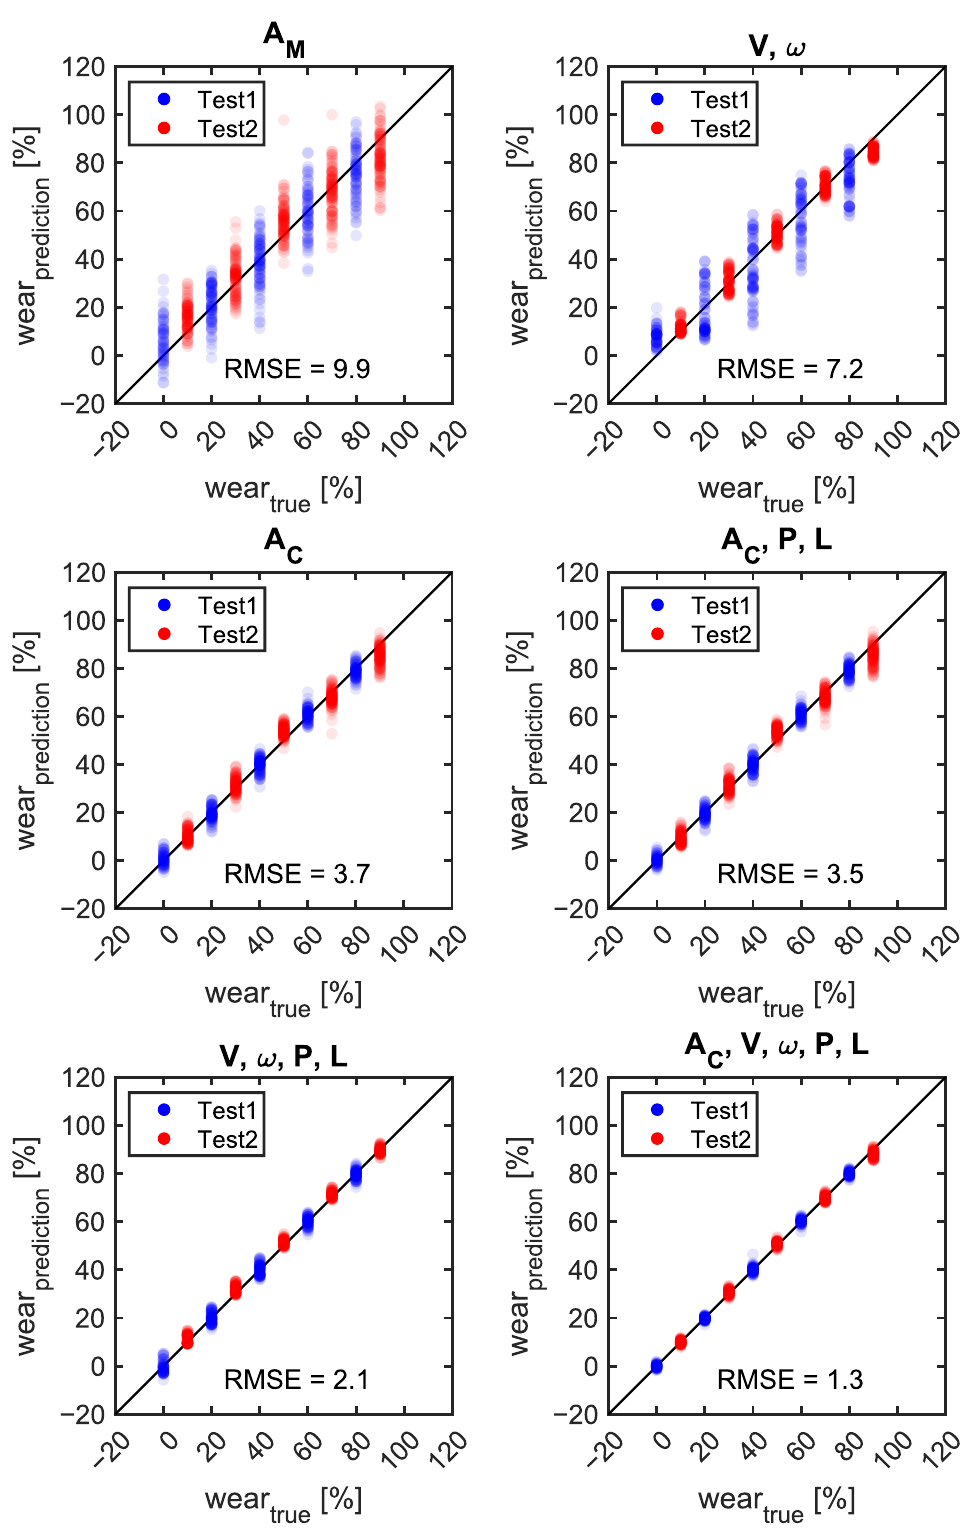
Figure 15. Scatter plots between the true and predicted wear amounts with respect to sets of fea- tures.